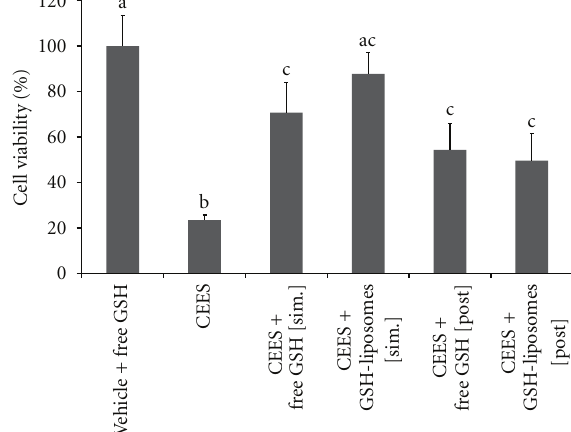
Figure 4: GSH-liposomes do not reduce apoptosis in the EpiDerm model . EpiDerm tissues were exposed topically to 2.5mM CEES or vehicle (1% DMSO) in the absence or presence of Blank liposomes (B-liposomes) or GSH-liposomes (as indicated) applied simultaneously with CEES or vehicle, but into the bottom media; the tissues were incubated at 37 ◦ C for 18 hours. Final “calculated” concentration of GSH was 10mM (see Section 2). Caspase-3 activity wasassayed in the tissue homogenatesby the caspase-3 assay (see Section 2). Blank: blank bu ff er (negative control); Staur.: 5 μ M staurosporine (positive control). Means not sharing a common letter are significantly di ff erent ( P < . 05).